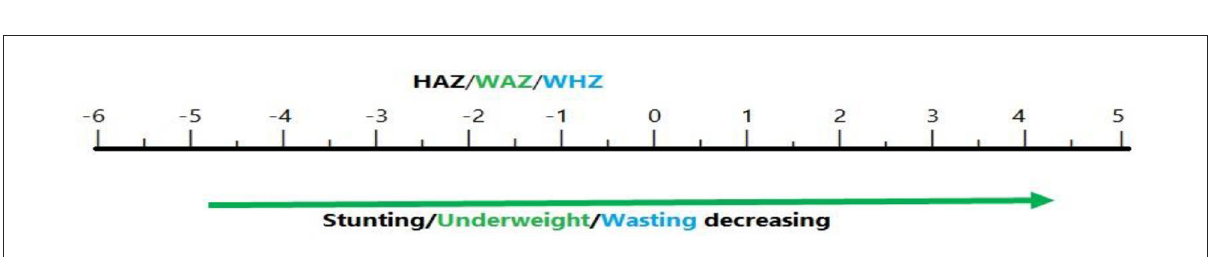
FIGURE2 Values of HAZ/WAZ/WHZ and patterns of